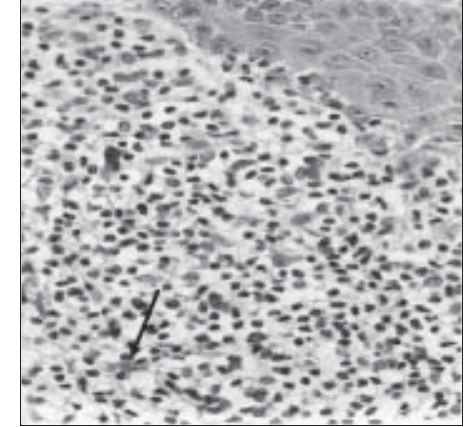
Figura 8 – Avaliação da acantose e presença de dentes de serra em 59 biópsias de líquen plano cutâneo e oral